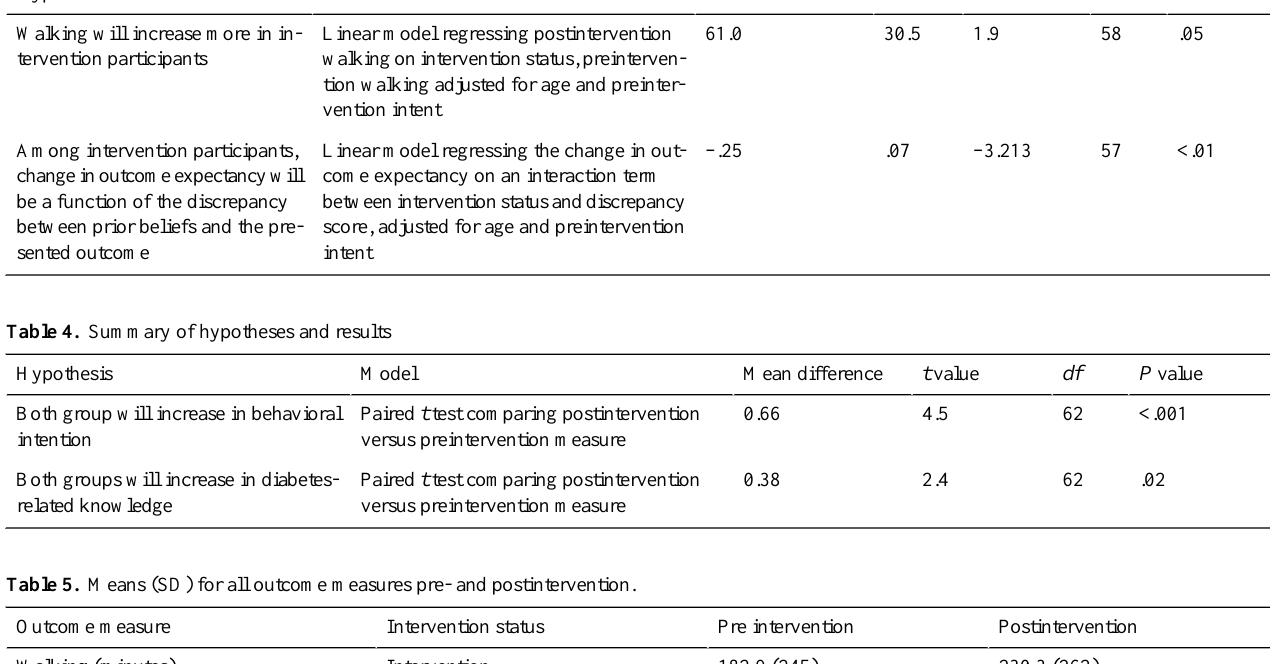
P value dft valueSECoefficientModelHypothesis